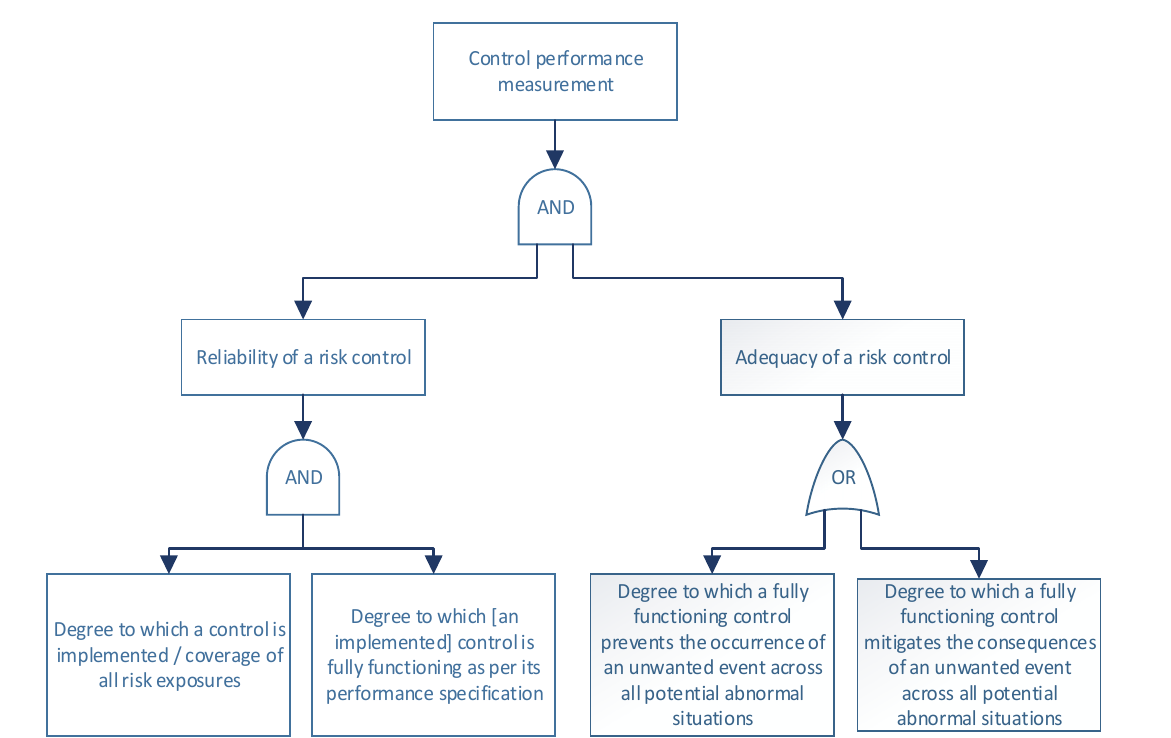
Figure 1. Measuring control performance .